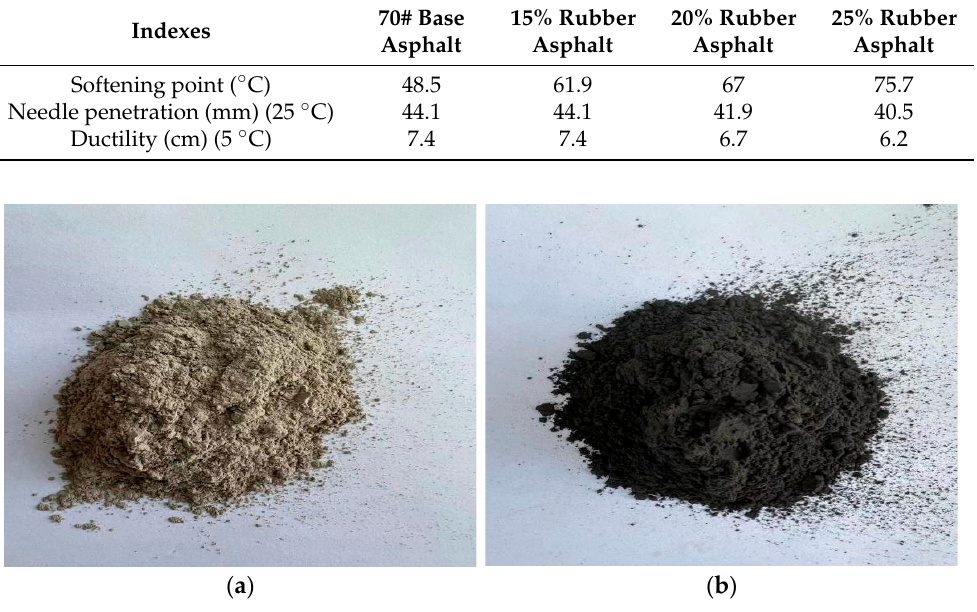
Figure 1. Sample of limestone powder and coal gangue powder: ( a ) Limestone powder; ( b ) Coal gangue powder. Table 2. Technical performance indicators of mineral powders.